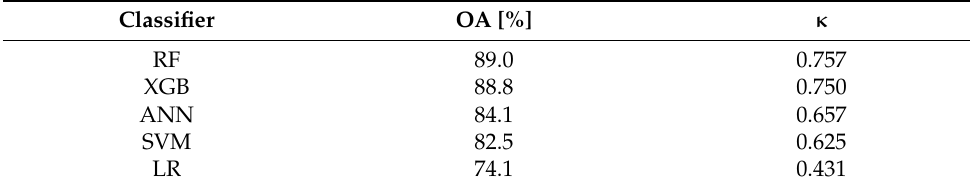
Table 6. Accuracy results of each classifier when predicted on test data.